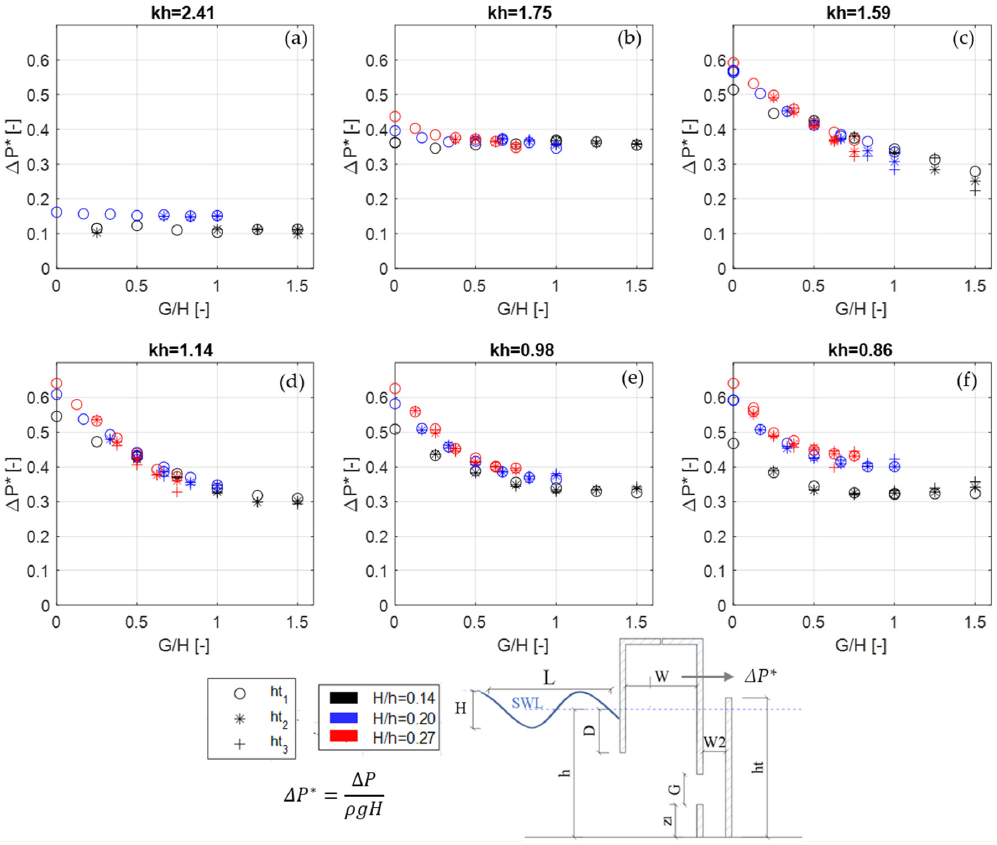
Figure 9. Dimensionless pressure parameter ∆ P* as a function of the relative size of the submerged aperture G / H for different relative water depths: kh = 2.41 ( a ), 1.75 ( b ), 1.59 ( c ), 1.14 ( d ), 0.98 ( e ), 0.86 ( f ).